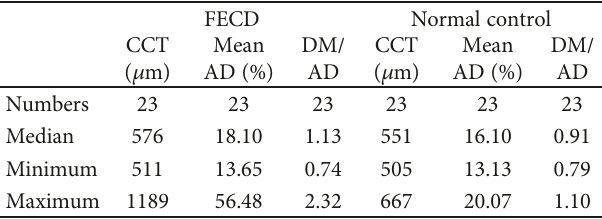
FECD: Fuchs ’ endothelial corneal dystrophy; CCT: central corneal thickness; Mean AD: average area density; DM/AD: average ratio of Descemet ’ s membrane density versus area